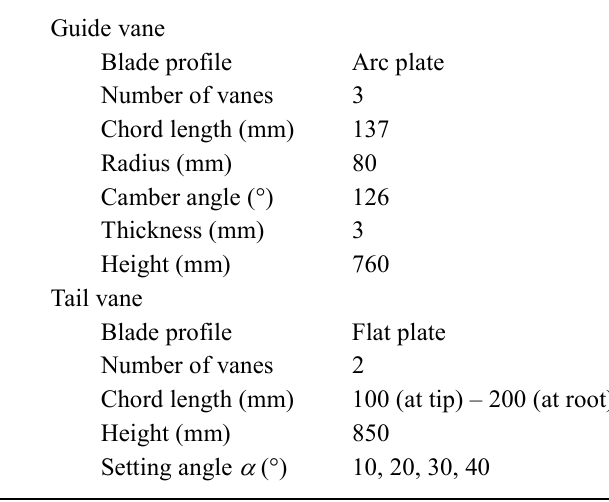
Specifications of guide vane and tail